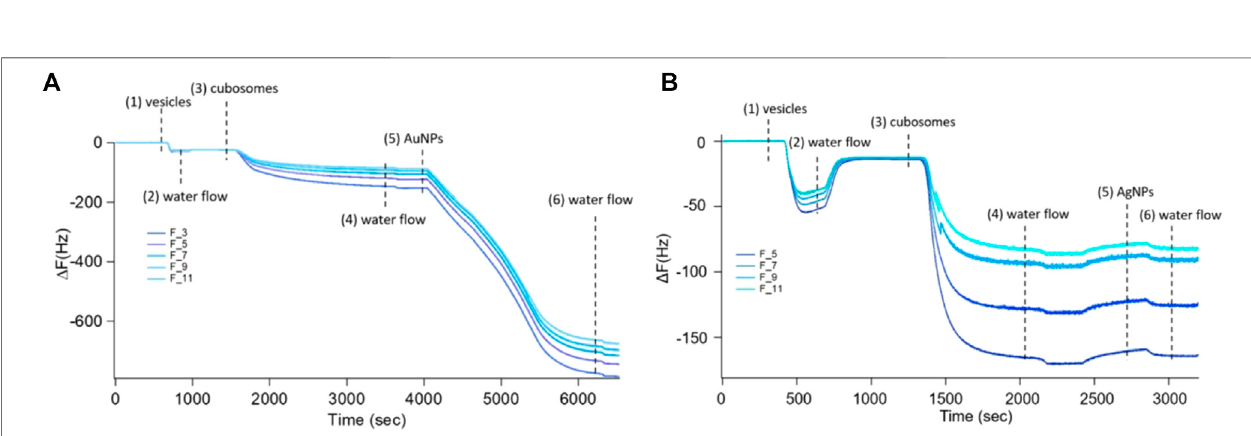
FIGURE 5 | QCM experiments describing the adsorption of 0.83 nM AuNPs (Panel (A) ) and AgNPs (Panel (B) ) on the cubosomes fi lm deposited upon the DOPC/ DOTAP substrate. The vertical lines represent the subsequential injection of DOPC/DOTAP vesicles (1), milliQ water (2), cubosomes (3), milliQ water (4), AuNPs (left) or AgNPs (right) (5), and milliQ water